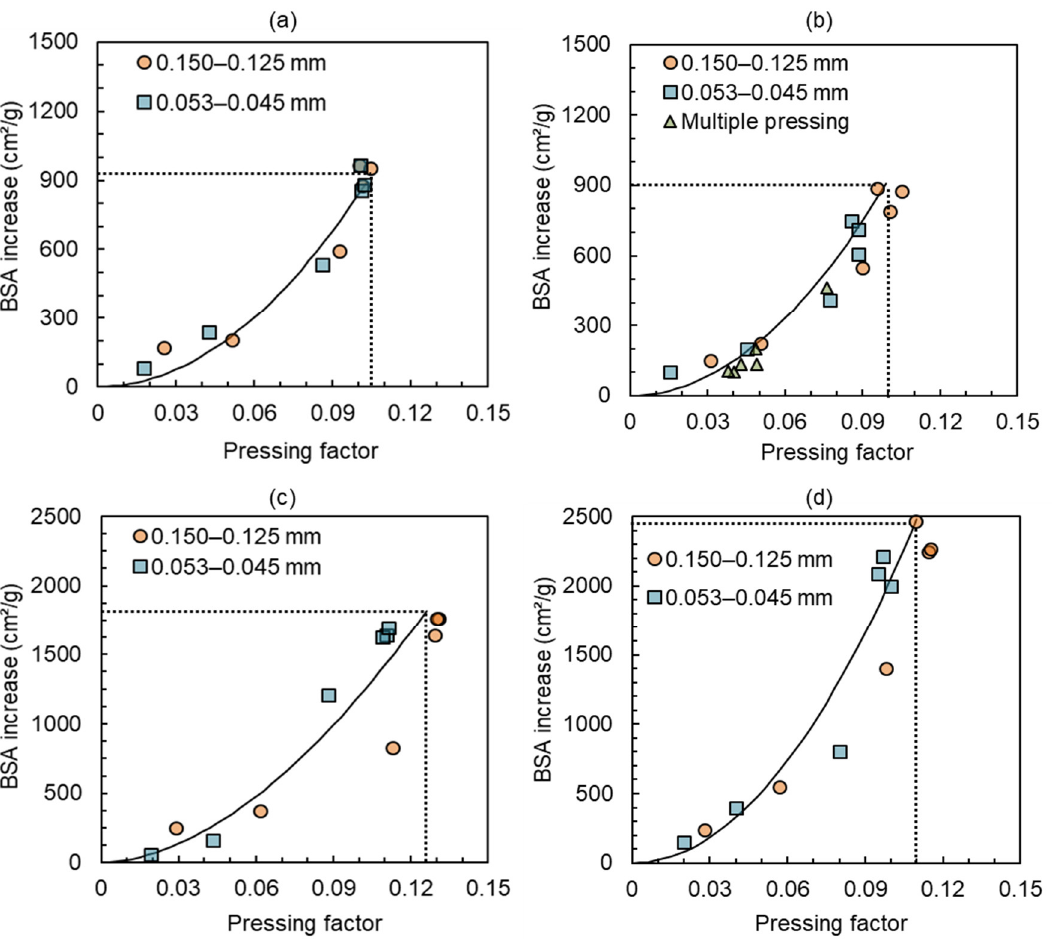
Figure 10. Relationship between BSA increase and pressing factor κ for the ( a ) Brucutu, ( b ) Itabira, ( c ) ( c ) Timbopeba, and ( d ) Caraj á s Timbopeba, and ( d ) Carajás samples.